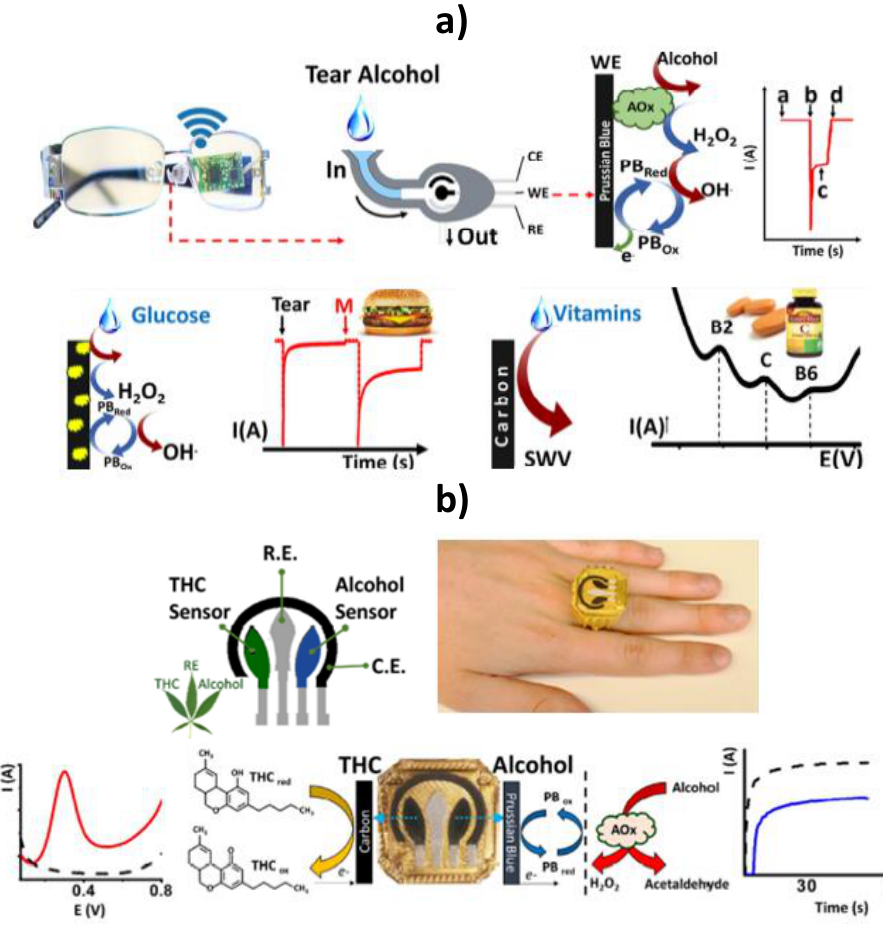
Figure 11. Schematic cartoon of the fluidic device, wireless electronics integrated into the eyeglasses platform, enzymatic detections of alcohol and glucose by chronoamperometry and non-enzymatic determination of vitamins by SWV in collected tears ( a ). Ring-based sensor platform embedded with marijuana designed sensor for detecting THC and alcohol in undiluted saliva samples using SWV and chronoamperometry ( b ). Reprinted and adapted with permission of Elsevier [85] ( a ) and [86] ( b ).